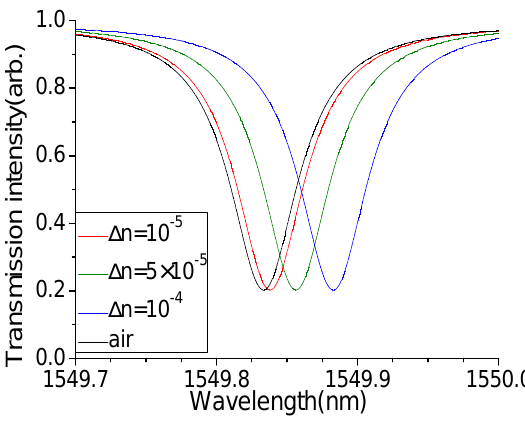
Figure 5. Sensing an extreme small variation of ambient refractive